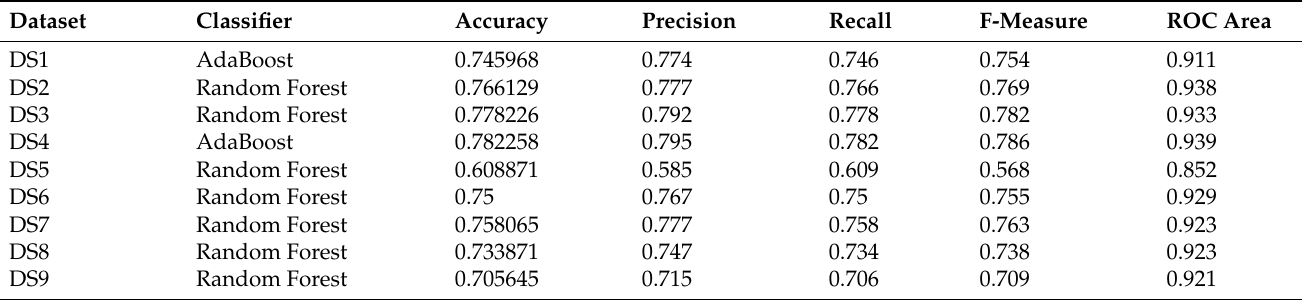
Table 9. Best classifier for each dataset according to receiver operating characteristic (ROC) area.